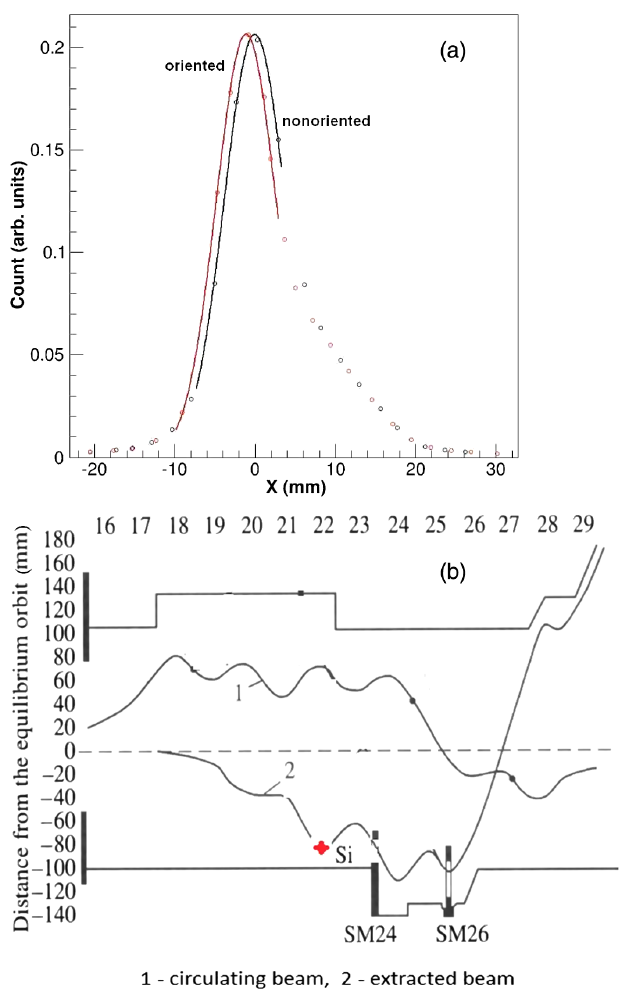
FIG. 6. (a) The beam profiles in orientation and nonoriented cases. (b) The scheme of SM24 septum shadowing in the U70